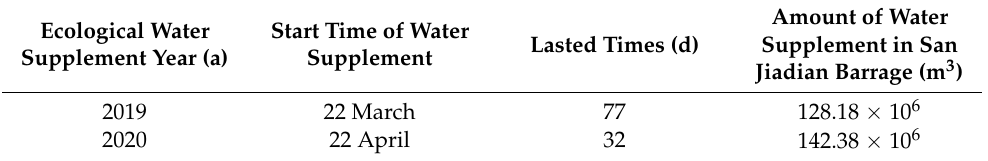
Figure 1. ( a ) Location map of the Yongding River ecological water supplement plains region (Beijing section). ( b ) Distribution map of the groundwater monitoring wells. Table 1. Ecological water supplement in the plain region of the Yongding River in 2019 and